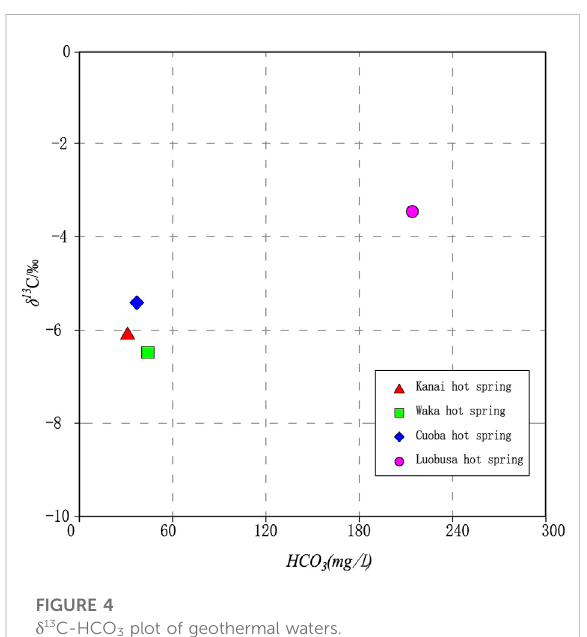
FIGURE 5 δ 2 H- δ 18 O plot of geothermal